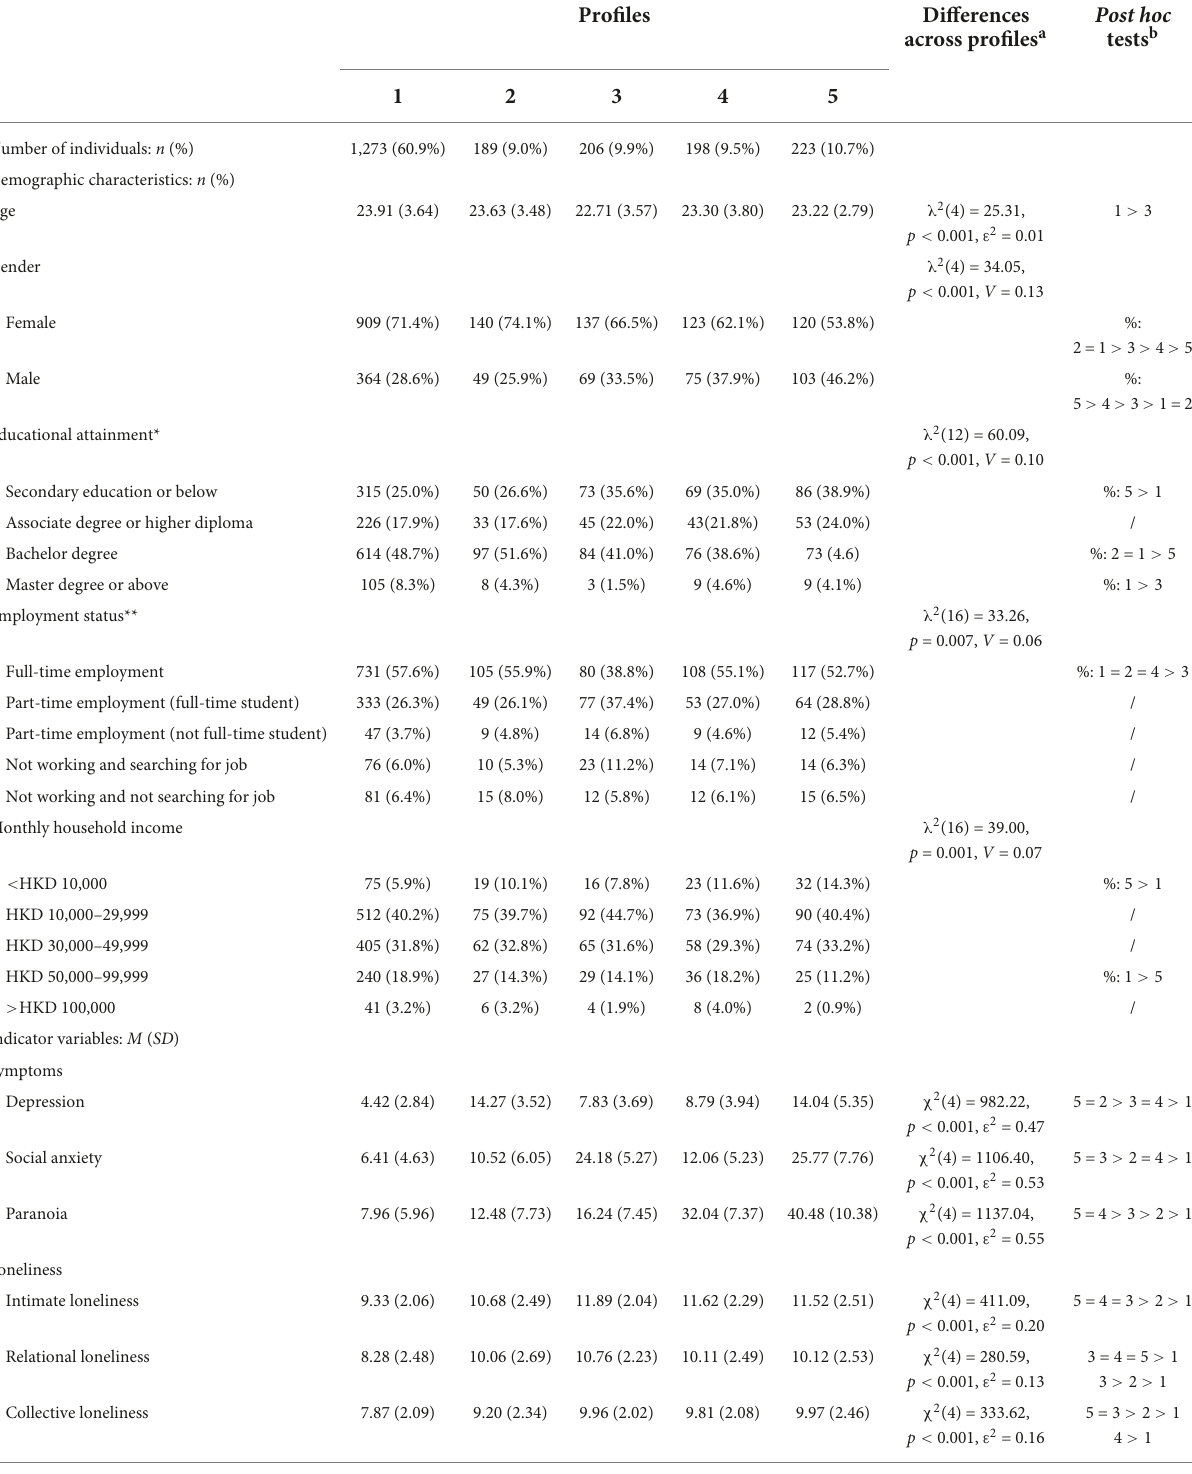
TABLE 3 Descriptive statistics of demographic characteristics, symptoms, and loneliness dimensions within identified profiles.